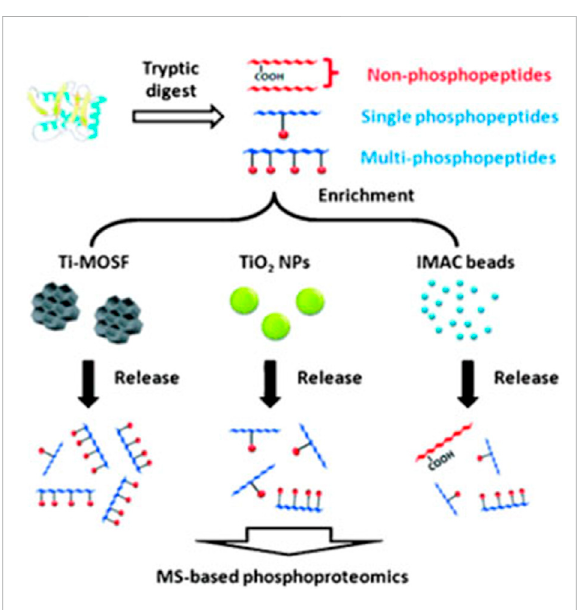
Schematic illustration of strategies employed for enriching